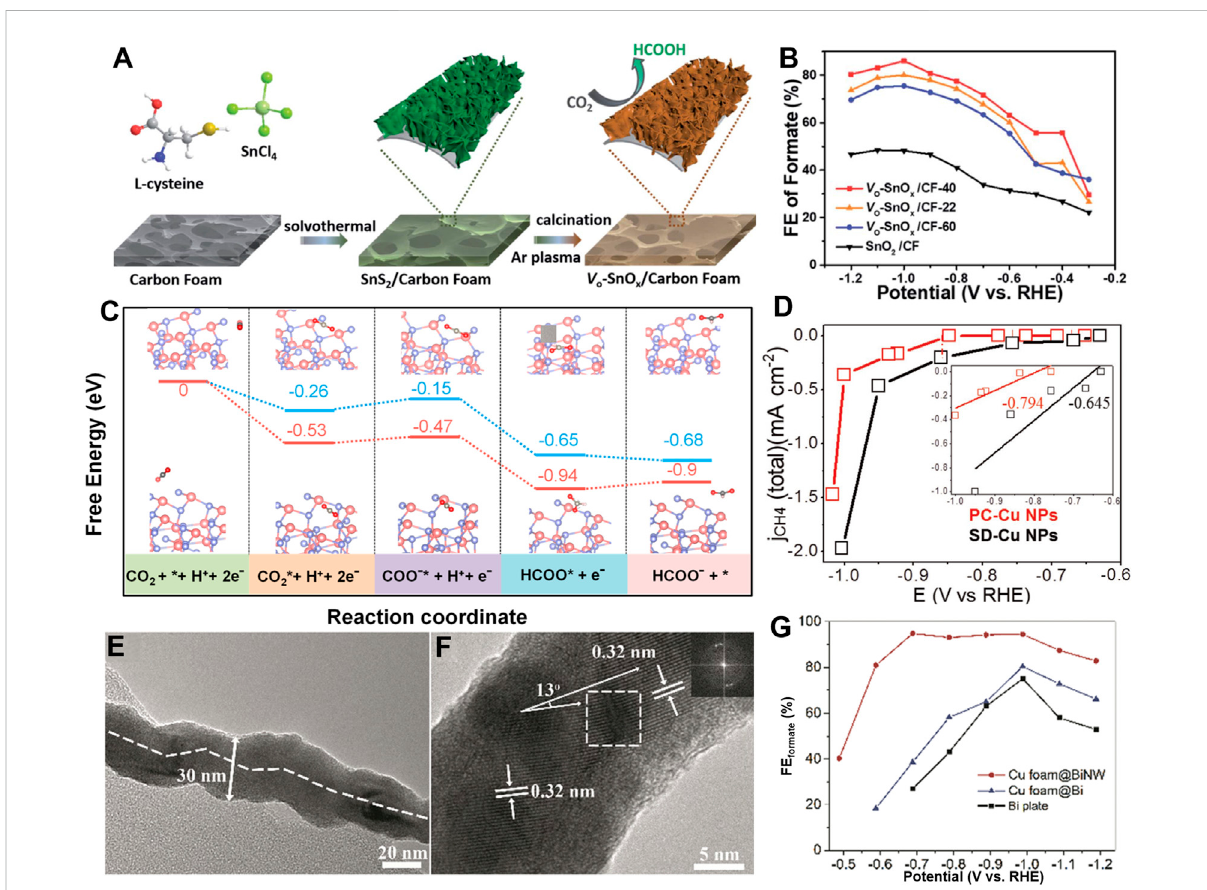
FIGURE 2 (A) Schematicillustrationofthefabricationprocessoftheoxygenvacancy-enrichedSnO x nanosheetsgrownoncarbonfoam. (B) FEofformate for various electrodes atdifferentelectrolyticpotentials. (Reproduced from (Li etal., 2020)with permission from theRoyal Society of Chemistry). (C) Free energy diagram for the pathways of CO 2 conversion into formate on a perfect ZnS and V Zn -ZnS surface. [Reproduced with permission from (Pang et al., 2019)]. (D) ECSA normalized CH 4 partial current density. [Reproduced with permission from (Choi et al., 2019)]. (E) TEM image of a BiNWshowingatwistedstructure. (F)